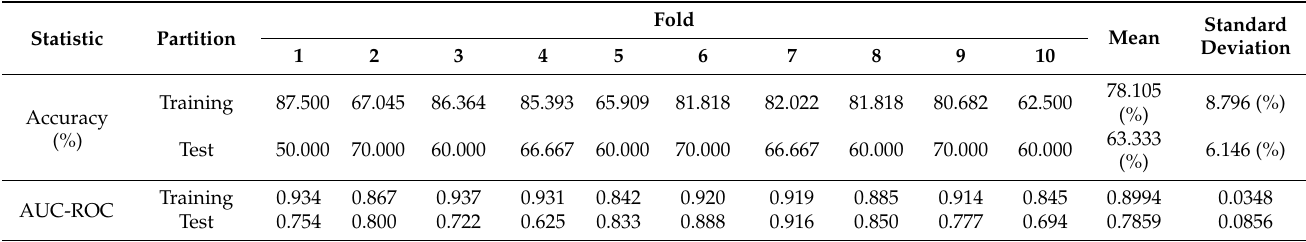
Table 4. The 10-fold cross-validation